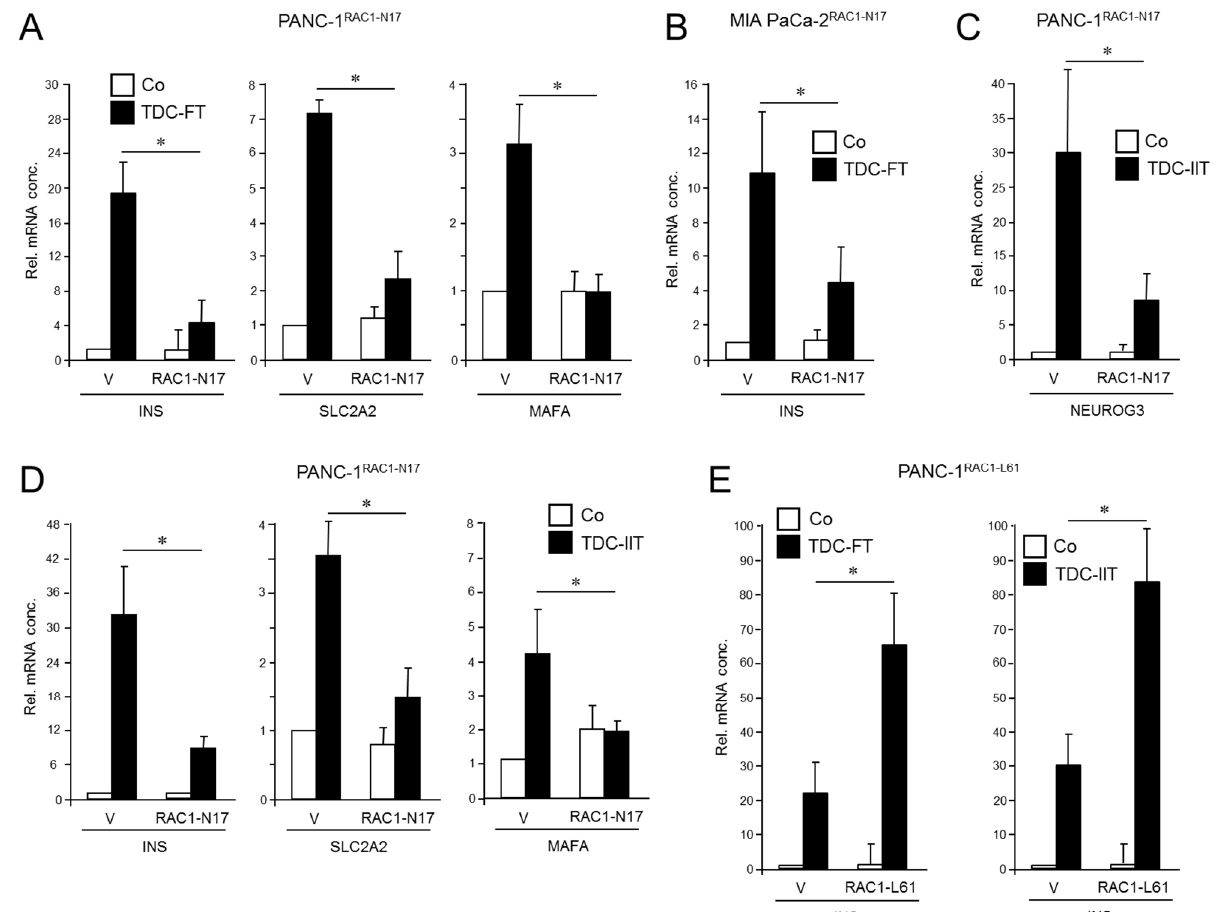
Figure 1. Effect of ectopic expression of non-activatable and constitutively active forms of RAC1 on a deTDtP in PANC-1 and MIA PaCa-2 cells. ( A ) PANC-1 cells stably expressing RAC1 N17 underwent TDC with FGFb + TF (FT) for 5 d and after lysis were monitored for β cell-specific gene expression by qPCR. ( B ) MIA PaCa-2 cells were transiently transfected with RAC1 N17 (or empty pRK5 vector) and subsequently subjected to TDC with FT for 5 d. INS mRNA was measured by qPCR. ( C ) PANC-1 cells stably expressing RAC1 N17 were subjected to TDC with IFN γ , IL1 β , and TNF α (IIT) for 3 d and assayed for expression of NEUROG3 by qPCR. ( D ) As in ( C ), except that PANC-1 cells were assayed for INS , SLC2A2, and MAFA . ( E ) PANC-1 cells were transiently transfected with RAC1 L61 , or empty pRK5 vector (V), subjected to TDC with FT (left-hand graph) or IIT (right-hand graph) and assayed for INS expression by qPCR. The data in ( A – E ) represent the mean ± SD of three assays each performed with technical replicates in triplicate. The asterisks ( ∗ ) denote significant differences ( p < 0.05, Wilcoxon test).